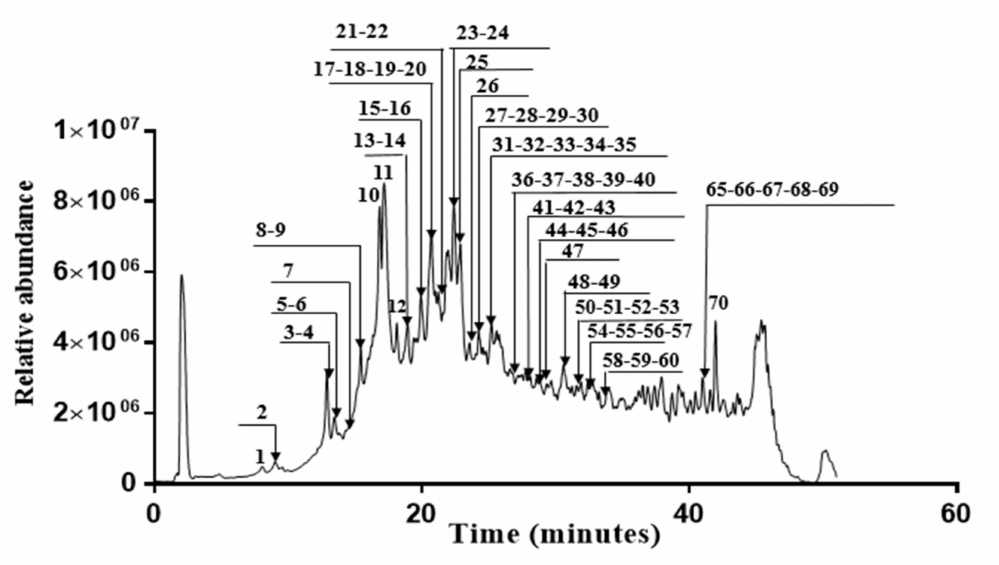
Figure 3. Chromatogram of acetone extract from the aerial parts of Erodium arborescens obtained by LC-HESI-MS analysis into negative